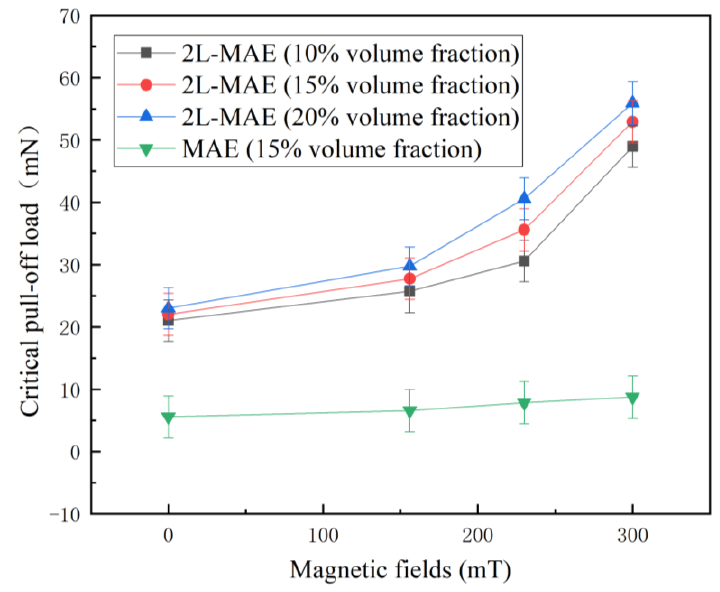
Figure 7. Critical pull-off load vs. external magnetic fields curves when the MAE samples detached from a wet acrylic substrate. from a wet acrylic